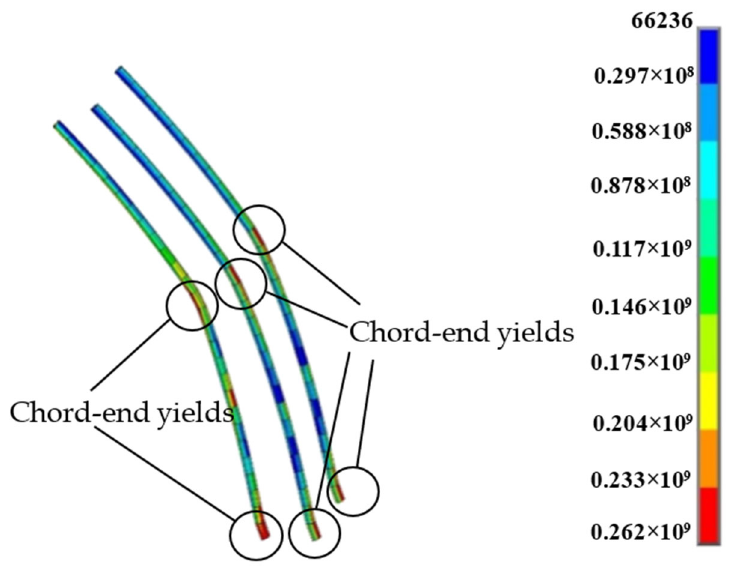
Figure 24. Chord stress distribution of chord and connecting plate combined failure (Pa).